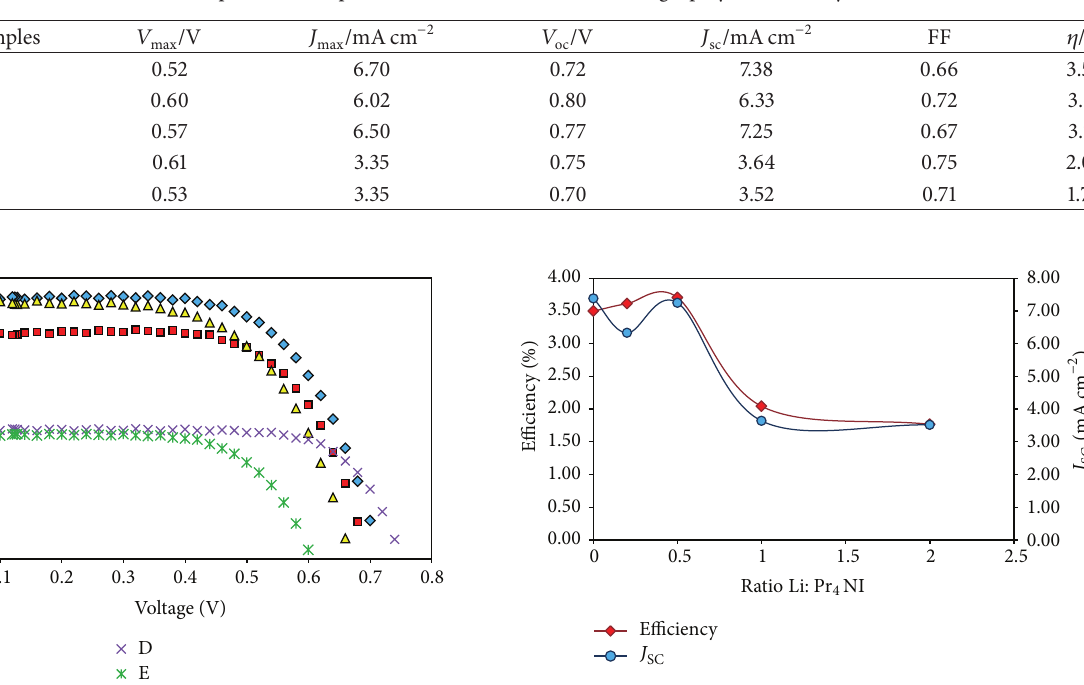
Figure 9: Dependence of 𝐽 and 𝜂 of DSSCs with different gel SC polymer